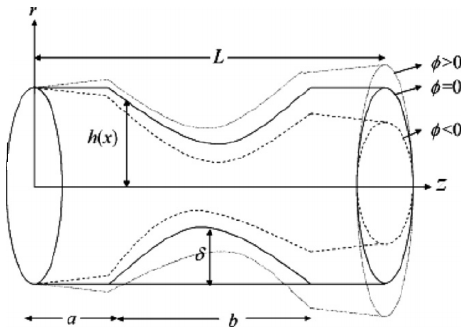
Fig. 2 Stenotic tapered artery for different taper